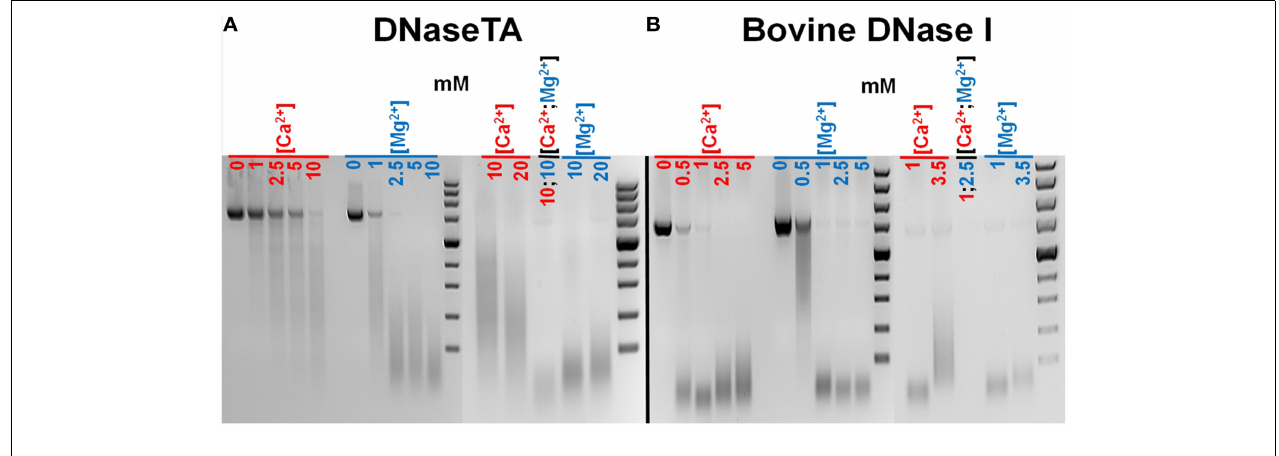
FIGURE 2 | Different requirements for divalent ions of DNase from Thioalkalivibrio sp. K90mix (DNaseTA) and bovine DNaseI. Several different concentrations of Ca 2 + and Mg 2 + were screened evaluating approximate optimum for DNaseTA (A) and bovine DNaseI (B) . It was found